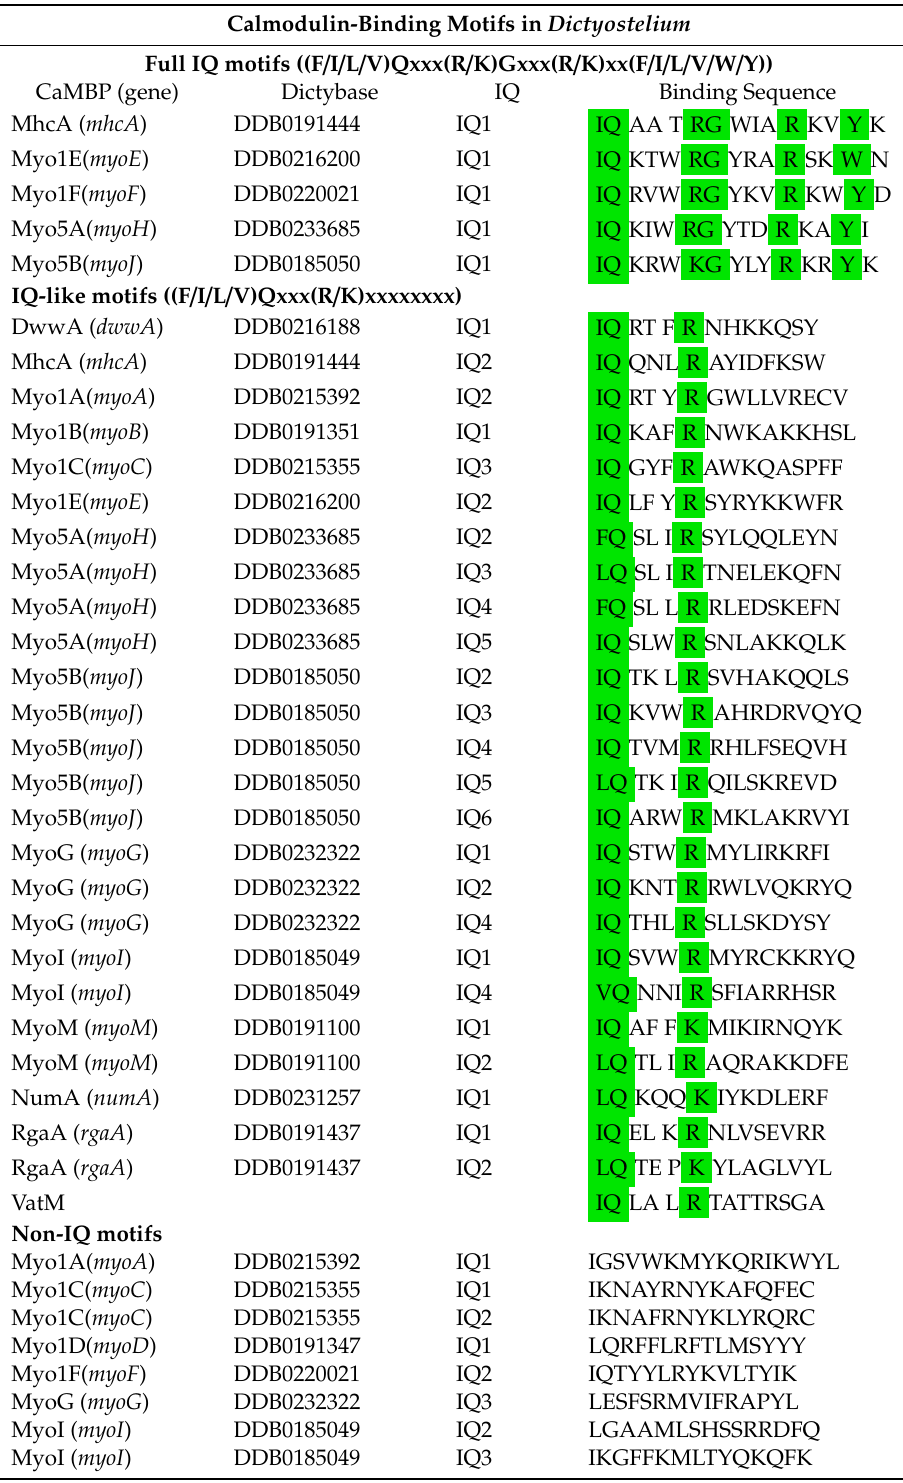
Table 3. Calcium-independent IQ, IQ-like, and non-IQ. Calmodulin-Binding Motifs in